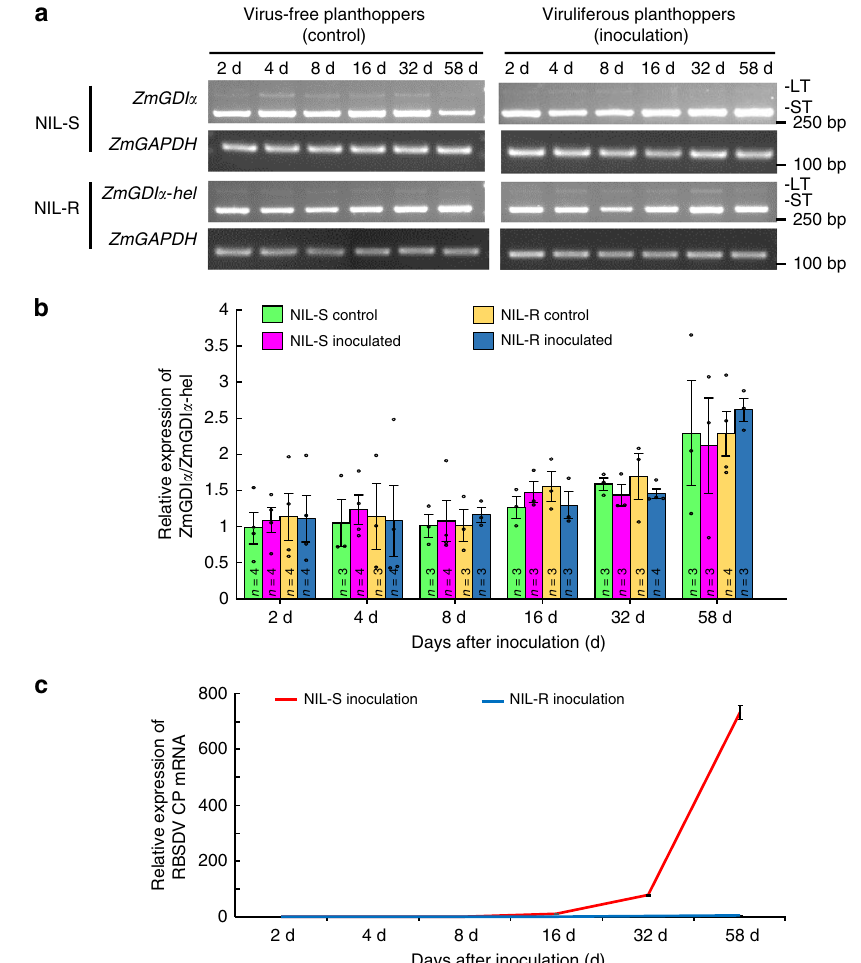
Fig. 3 Expression pro fi les of ZmGDI α / ZmGDI α -hel and RBSDV accumulation. a The dynamic changes of two transcripts during viral infection. The long and short transcripts were simultaneously detected by RT-PCR at 2, 4, 8, 16, 32, and 58 days after inoculation. ZmGAPDH was used as an internal control. LT long transcript, ST short transcript. b Relative expression levels in ZmGDI α and ZmGDI α -hel . The values are denoted as mean ± SEM. Three or four samples were taken as biological replicates ( n ). Each dot indicates the expression level of a single biological replicate. c The relative expression of RBSDV coat protein (CP) mRNA. The number of samples is consistent with that in “ b ” . The values are denoted as mean ± SEM. Red line: inoculated NIL-S; blue line: inoculated NIL-R. Each of above three experiments was repeated three times independently, with the similar results. Source data are provided as a Source Data fi